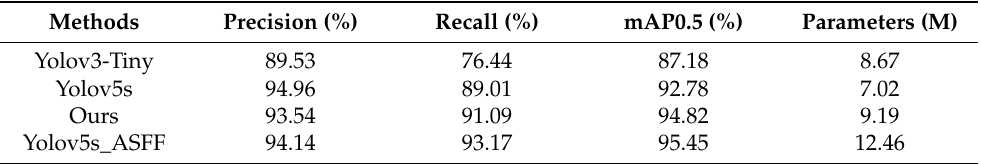
Table 2. Results of comparison of target detection